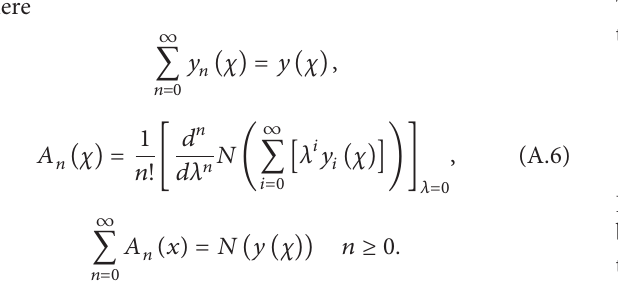
(17), (b) substrate 𝐹 O = 0.5 . (vii) 𝐵 S